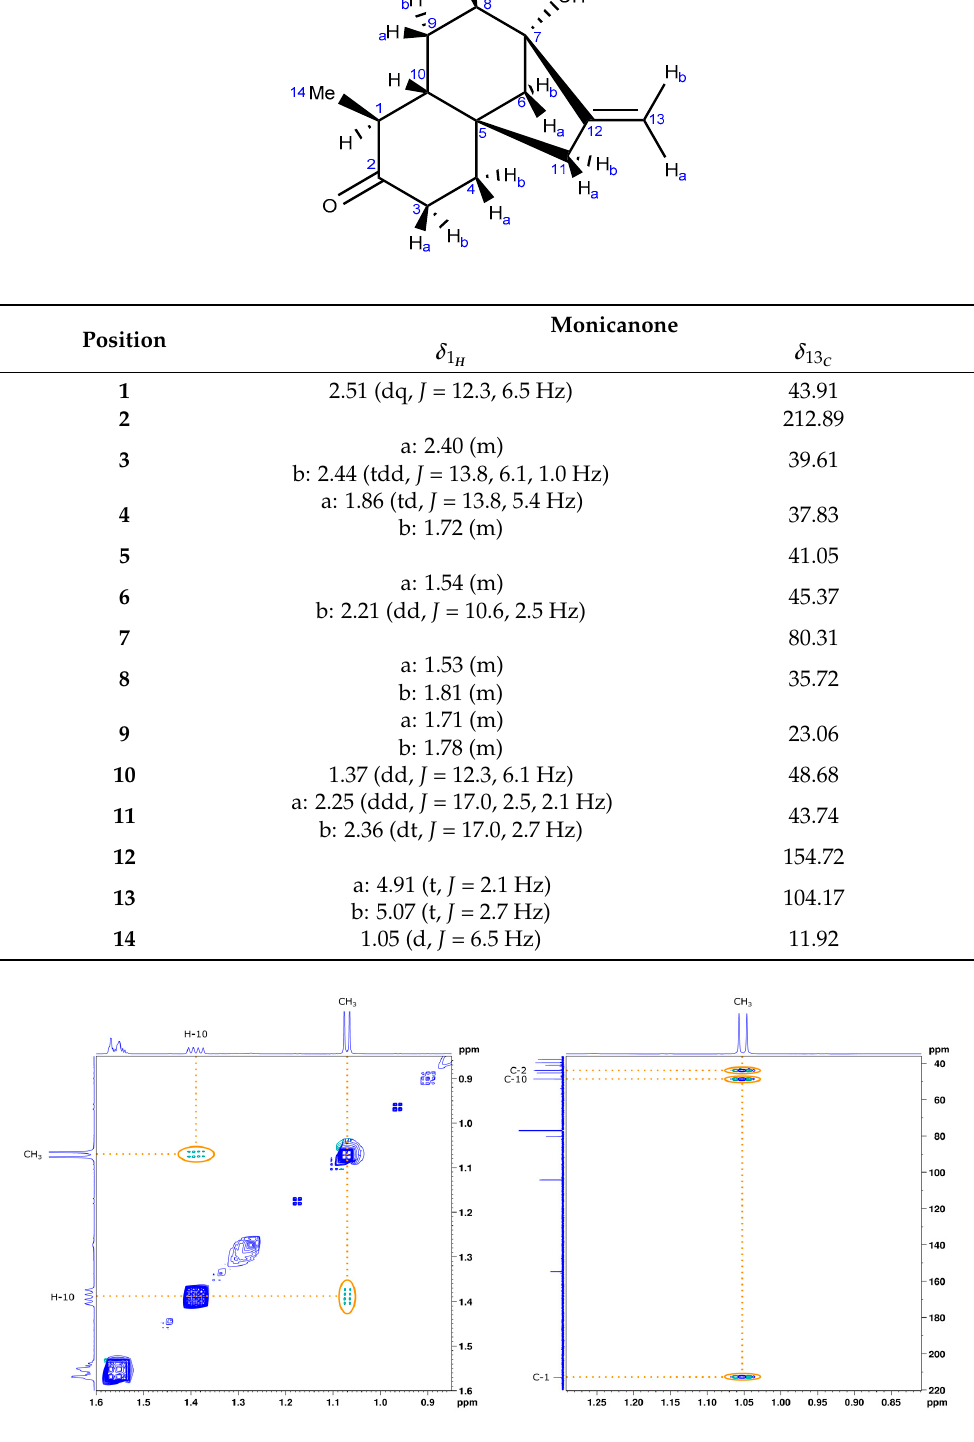
Table 1. 1 H (600 MHz) and 13 C (151 MHz) NMR data and structure of monicanone. Spectra are recorded at 298 K in CDCl 3 . Coupling constants are matched amongst the different multiplets. For the unmatched coupling constants, please refer to Supplementary Materials S1 page S-2. First-order analysis has been applied.